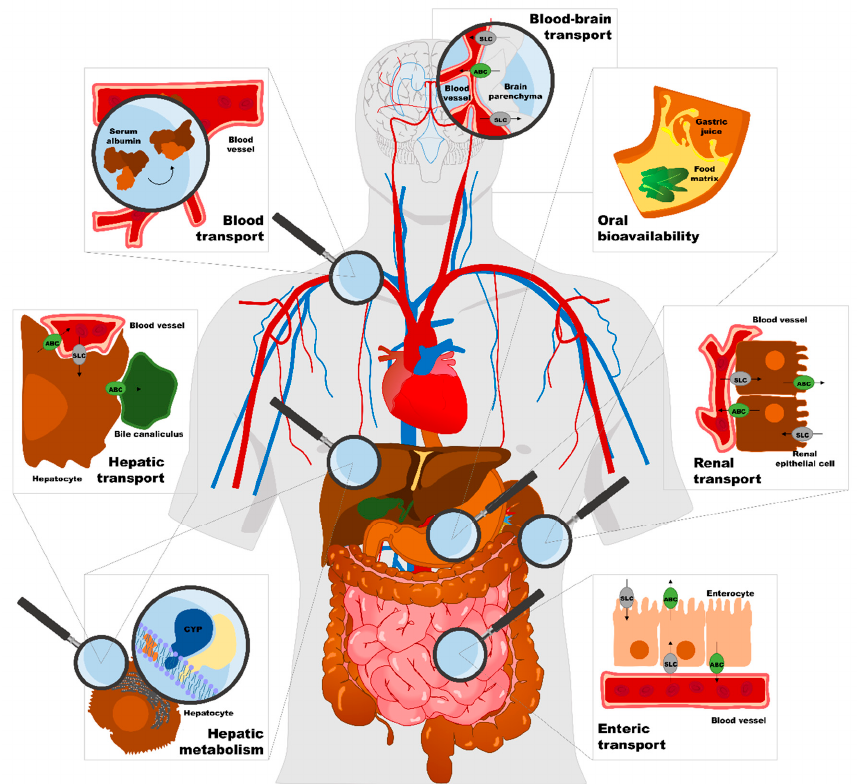
Figure 1. Major sites of food-drug interactions. SLC = solute carrier proteins, ABC = ATP-binding cassette proteins, CYP = cytochrome P450.